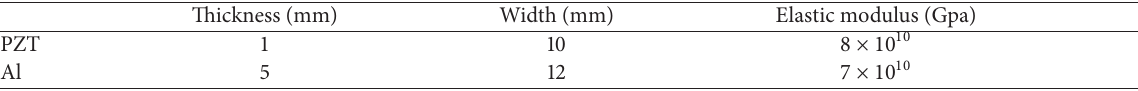
Table 7: Related parameters of PZT and aluminum.